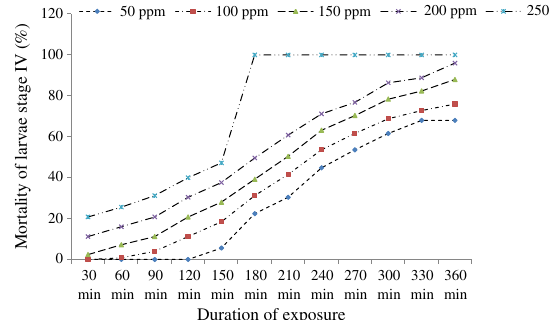
Figure 2. Percentage of mortality of stage IV larvae of Anopheles funestus s.s. depending on the duration of exposure to different concentrations of the essential oil of Cymbopogon citratus .